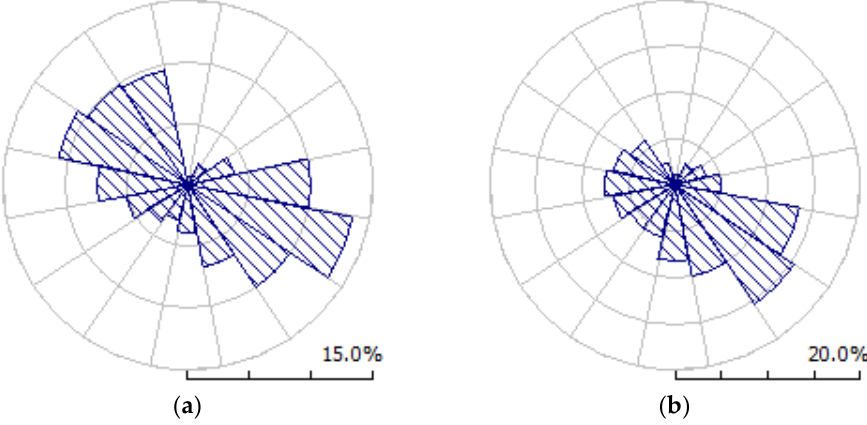
Figure 6. The wind rose for the ( a ) Charfashion and ( b ) Monpura microsites at 10 m AGL. The power law exponent (PLE) value α, as derived from Equation (3), varies with the varying temperature. The ambient heat influences the atmospheric boundary layer movement and it significantly affects the PLE value. The PLE value is usually higher during the night, as the temperature decreases at night time, causing the wind above the ground to become cooler, thus providing denser air [27]. The diurnal variations for the power law exponent and air density for the two selected sites are shown in Figure 6. Additionally, the yearly average air density of the sites is presented in Table 6, as its calculation is important for the understanding of the varying nature of wind speed at different heights.